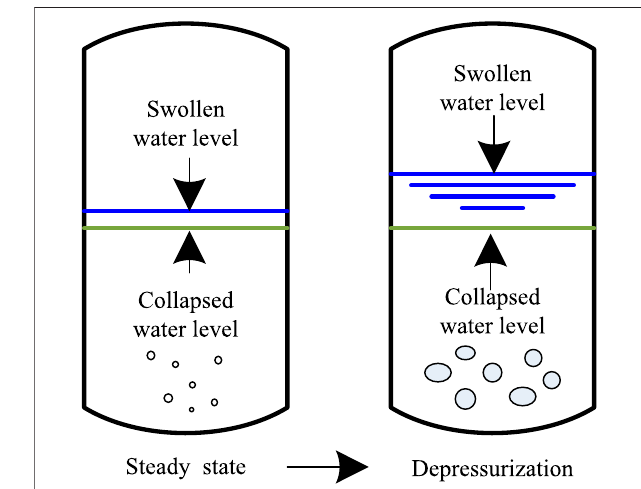
FIGURE 5 | Swollen and collapsed levels in the vessel.